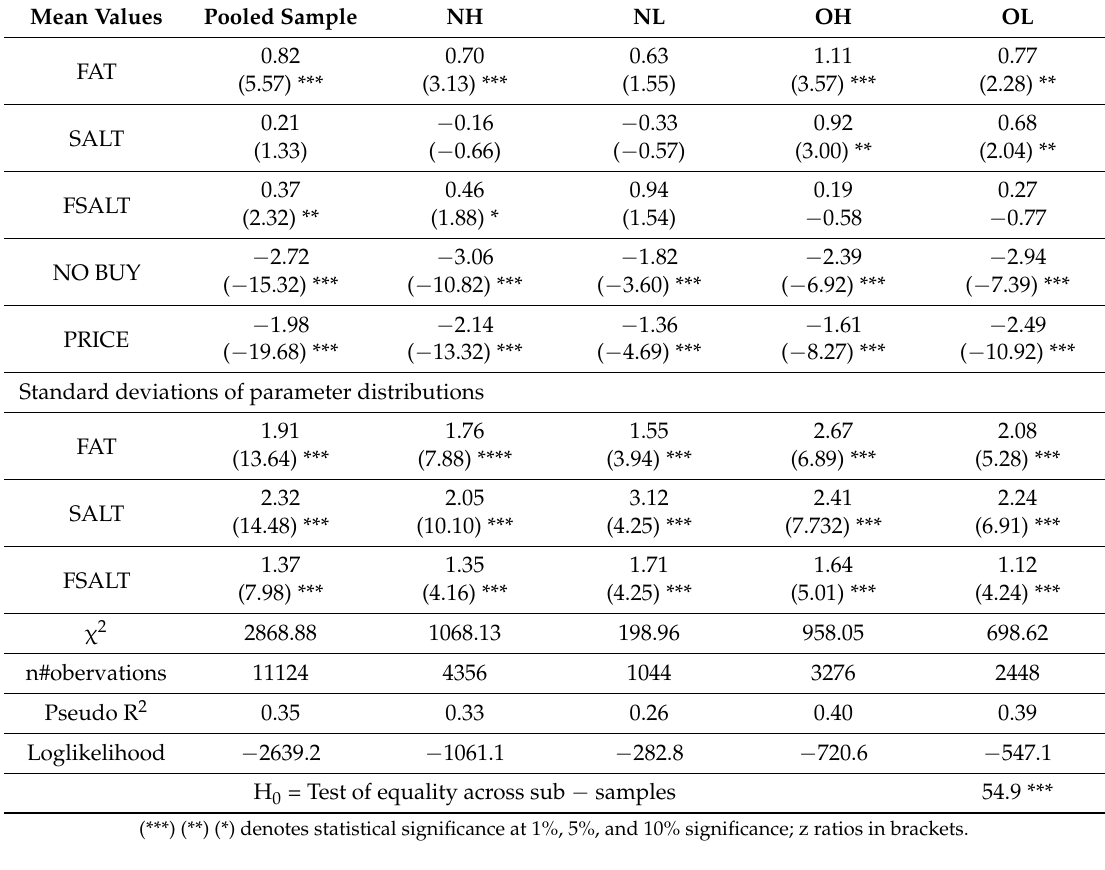
Table 3. Parameter estimates of Random Parameter Logit (RPL) for pooled sample and the four groups.